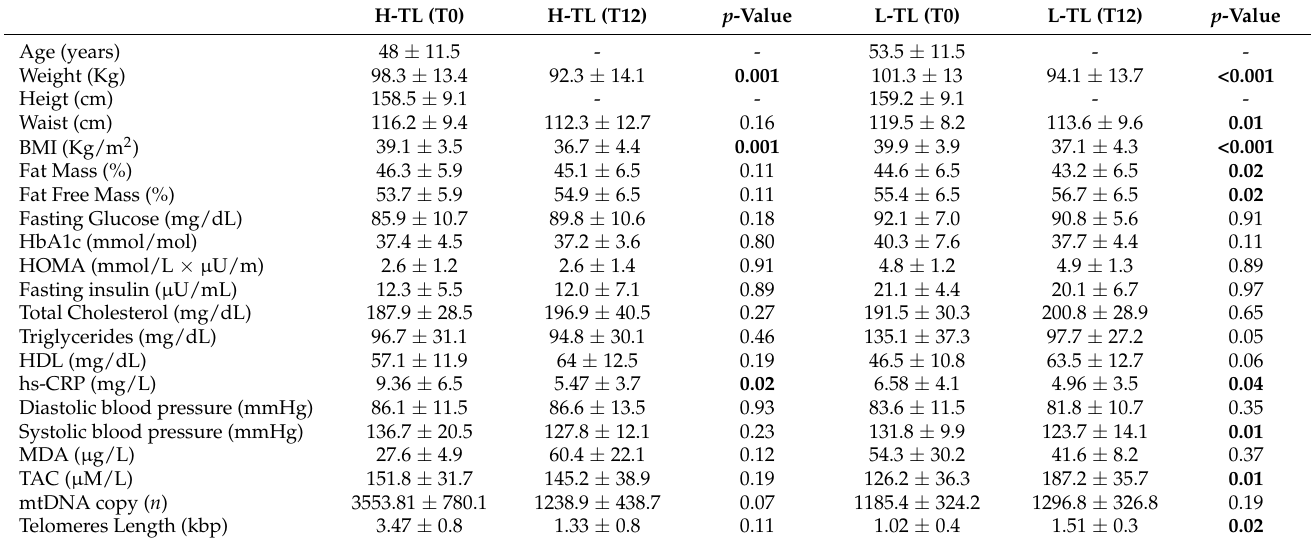
Abbreviations: the lower than median group (L-TL group) and the higher than median group (H-TL group); BMI (Body Mass Index); HbA1c (Glycosylated Hemoglobin, Type A1C); HOMA (homeostatic model assessment); hs-CRP (high-sensitivity C-reactive protein); MDA (Malondialdehyde); TAC (total antioxidant capacity); mtDNA (mitochondrial DNA). Data are expressed as mean ± Standard Deviation (SD); a p -value < 0.05 was considered statistically significant (indicated in